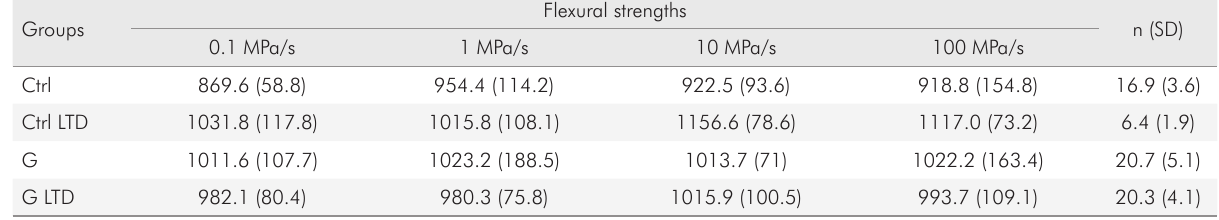
Table 3. Flexural strength means and respective standard deviations in each stress rate and slow crack growth susceptibility (n). Groups